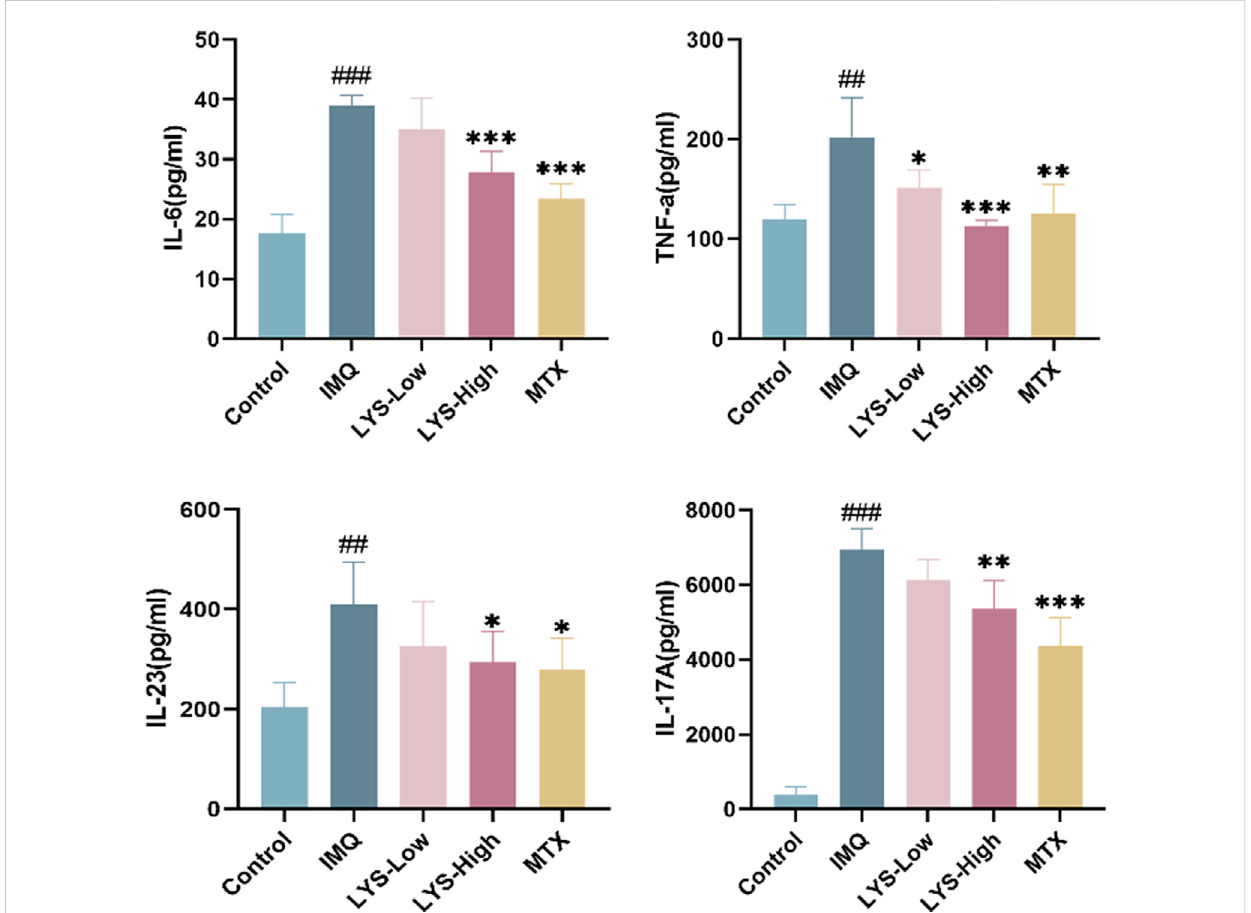
FIGURE 4 Effects of LYS on the serum levels of the in fl ammatory cytokines in IMQ-induced mice with psoriasis. IL-6, TNF- α , IL-23, and IL-17 levels were measured using ELISA. The data are expressed as mean ± SD ( n = 7). ## p < 0.01 vs. the control group; p < 0.05, ** p < 0.01, and *** p < 0.001 vs. the IMQ